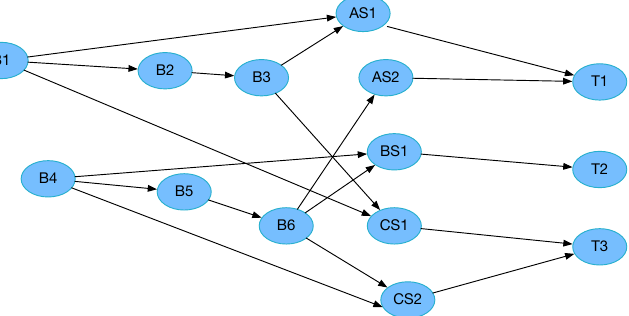
Figure 8. Proposed Bayesian network model (please refer to Tables 1 and 3 for the meanings of the